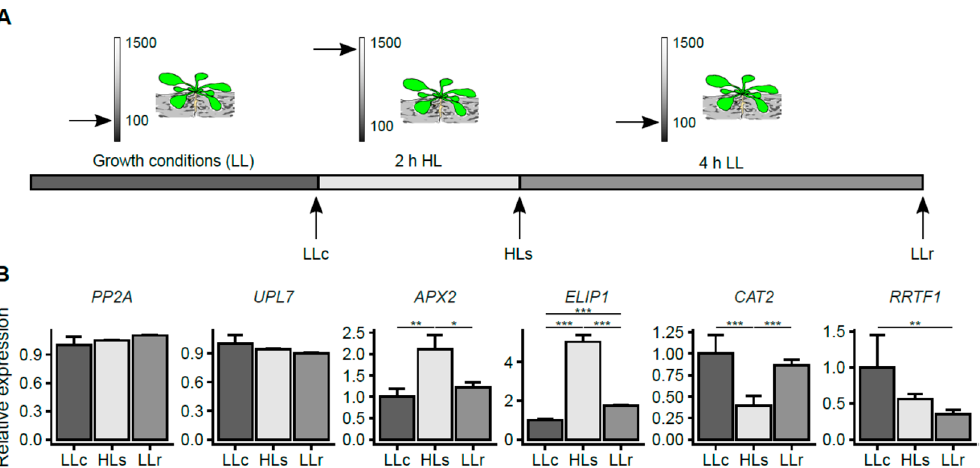
Figure 1. The transcriptional response of stress markers in Arabidopsis thaliana roots after the exposure of rosettes to high light intensity (HL). ( A ) Experimental scheme: LLc: roots of plants grown in low-light (LL) control conditions (2 h after the LL day started); HLs: roots of plants exposed to 2 h of HL stress; LLr: roots of plants exposed to 2 h of HL followed by 4 h of recovery in LL conditions. The arrows on the scales indicate the light intensity ( µ mol photons m − 2 s − 1 ). ( B ) Relative expression of the marker genes compared to the genes PP2A and UPL7 . Error bars represent the standard deviation, and asterisks represent significant di ff erences at p -values < 0.05 (*), < 0.01 (**), and < 0.001 (***). ANOVA and the HSD Tukey test were applied for statistical analysis. Results from two independent experiments were each pooled from six plants and three technical replicates.